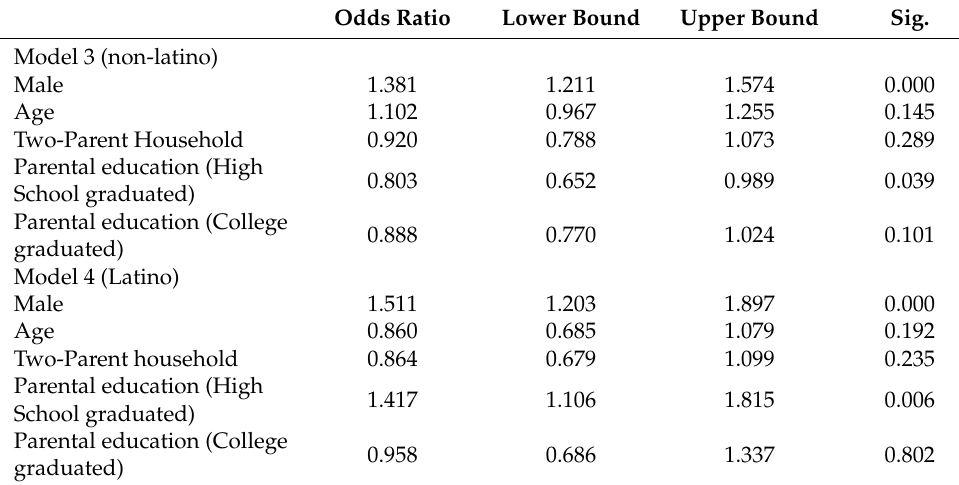
Table 3. Stratified models in non-Latino and Latino